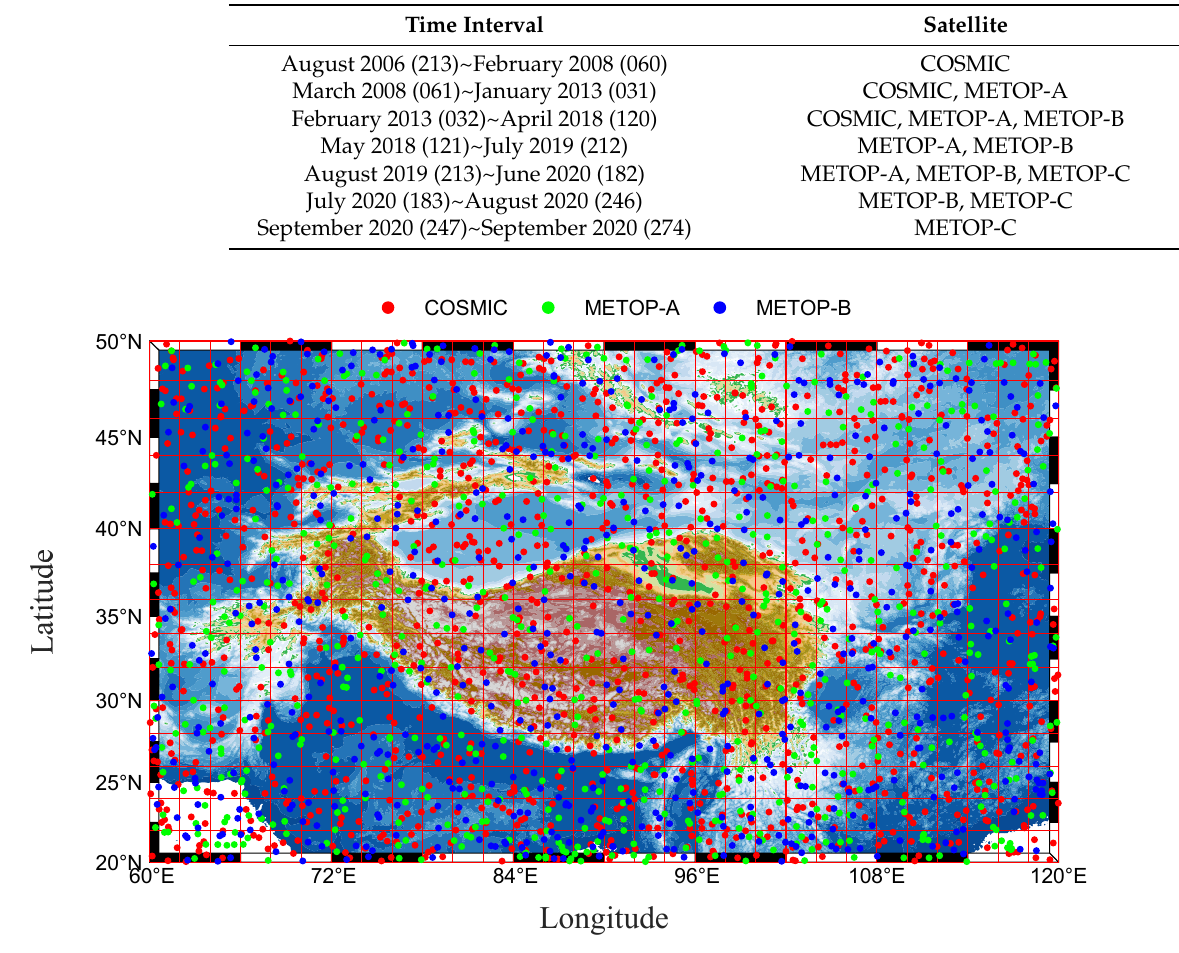
Figure 3. The distribution of RO events around TP (20~50 ◦ N, 60~120 ◦ E) in January 2015. Red dot, COSMIC RO event; green dot, METOP-A RO event; blue dot, METOP-B RO event.